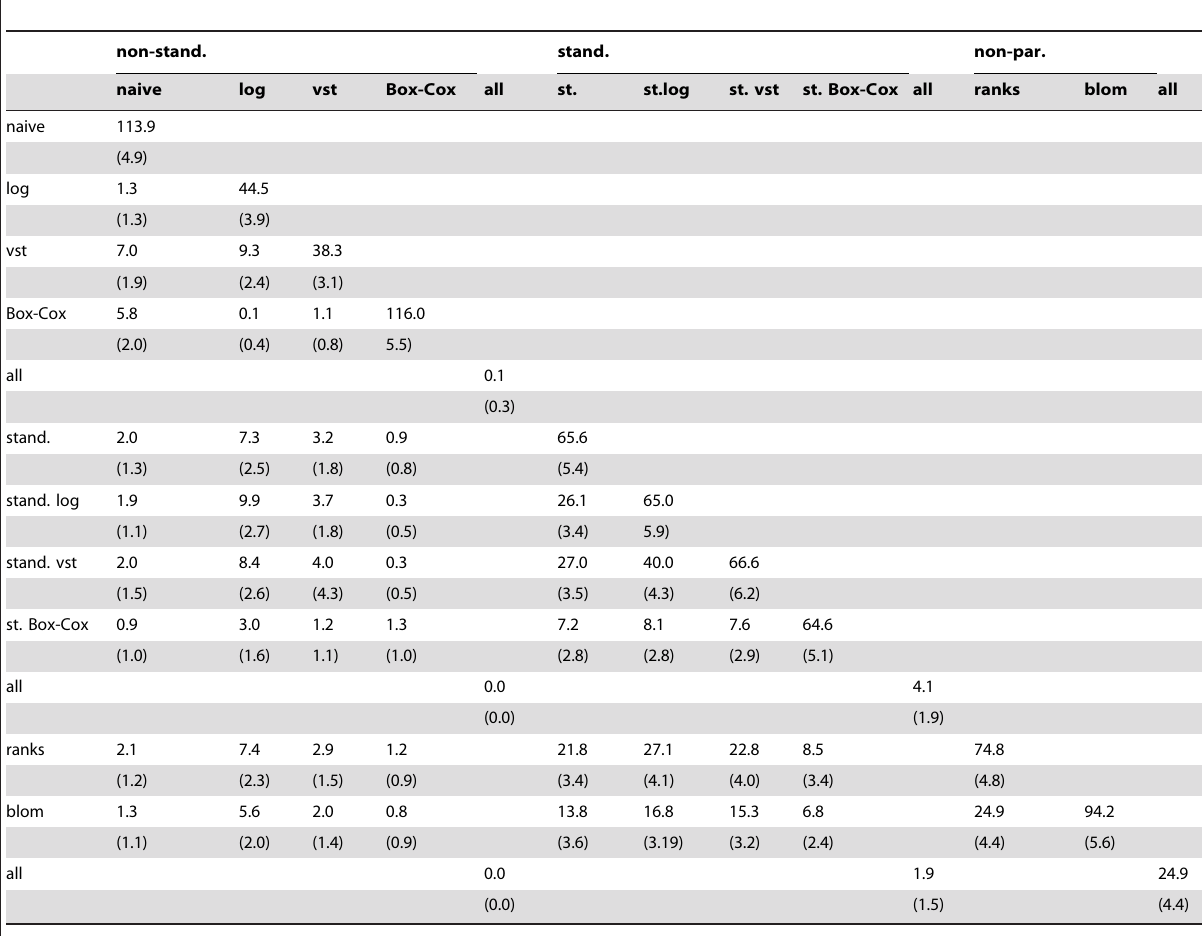
Table 2. KIRC data: Number of selected genes in a CoxBoost model of the KIRC data.